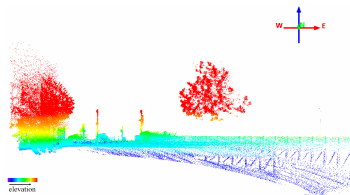
Figure 2. Interpolation of pixel values with a second order polynomial. P1, P, P2 illustrate the locations of three pixels as points placed in the middle of the pixels. W1, W and W2 are the corresponding pixel values.